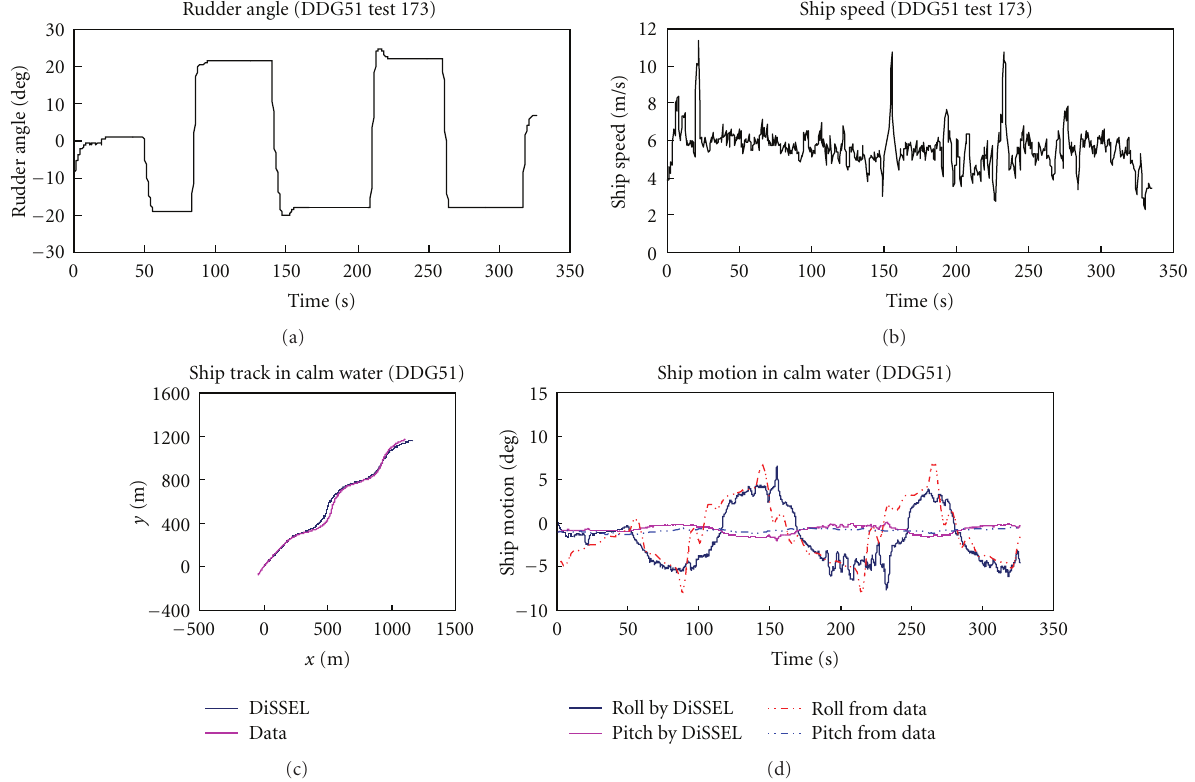
Figure 4: The data input for case 4 are shown in (a) and (b). (a) Rudder angle from data in test 173, (b) ship speed from data in test 173. The benchmark simulations for case 4 are shown in (c) and (d). (c) Comparison of ship track between simulations and data in test 173. (d) Comparison of roll and pitch motions between simulations and data in test